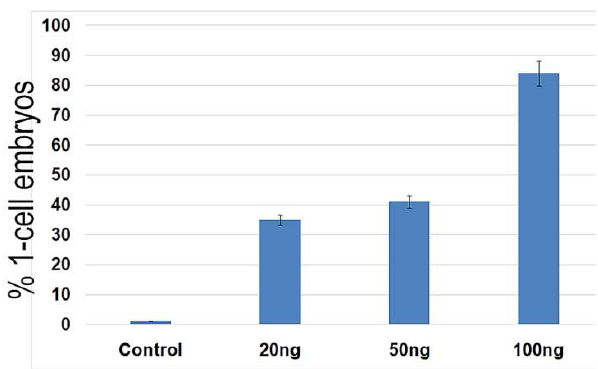
Figure 7. Still images form a time-lapse recording of one-cell mouse embryo expressing H2B-GFP during the first mitosis. The misalignment of chromatin is visible before the cleavage process (arrowheads) as is a micronuclear body in one blastomere of a two-cell embryo (arrow). Additionally, see Movie S1 in the Supplementary Data. Scale bar = 20µm.